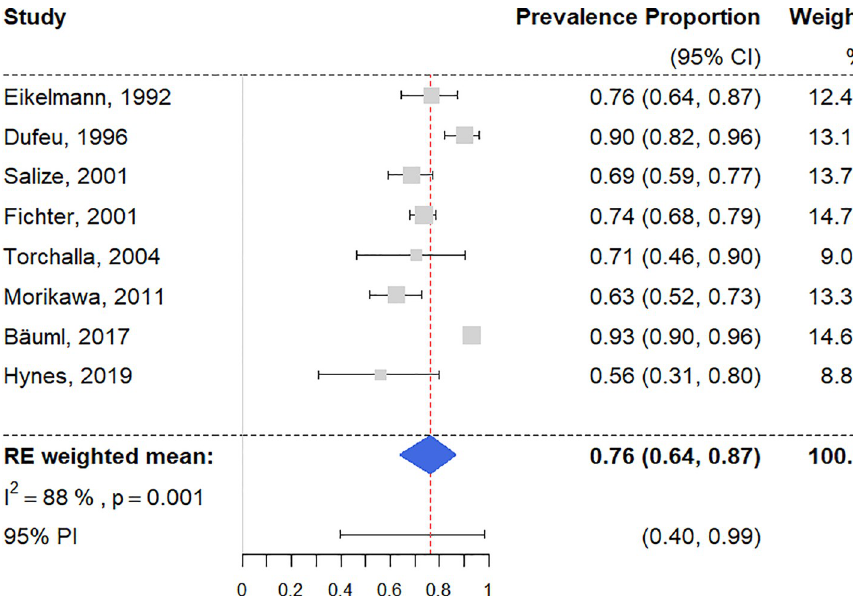
Fig 2. AU : PleasecheckthattheeditstothetitleofFig 2 arecorrect : Ifnot ; pleaseeditasnecessary : Forest plot of prevalence estimates of any current mental disorder. AU : InFig 2 ; shouldHynes ; 2018 beHynes ; 2019 ½ 62 � ? Ifso ; pleasefixinFig 2 ; or ð secondbest Þ addwordingtothefigurelegendclarifyingthatHynes ; 2018 refersto ½ 62 � : Analytic weights are from random effects meta-analysis. Grey boxes represent study estimates; their size is proportional to the respective analytical weight. Lines through the boxes represent the 95% CIs around the study estimates. The blue diamond represents the mean estimate and its 95% CI. The vertical red dashed line indicates the mean estimate. CI, confidence interval; PI, prediction